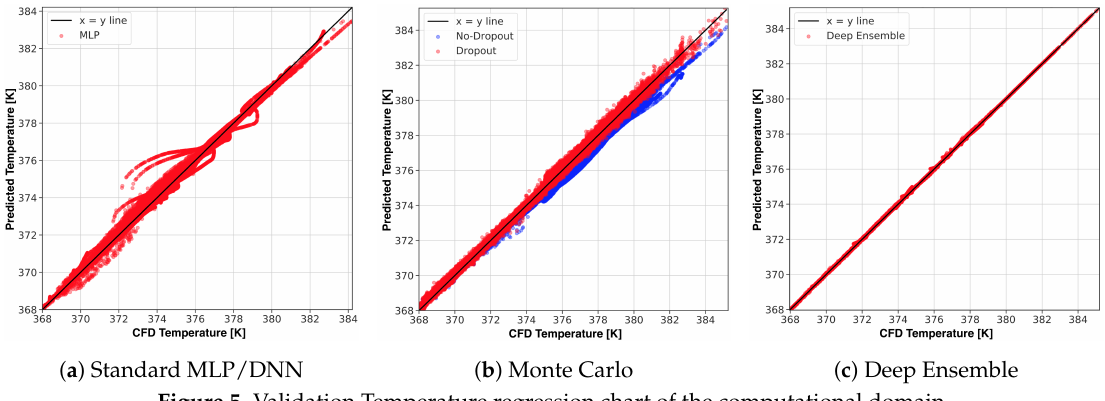
Figure 5. Validation Temperature regression chart of the computational